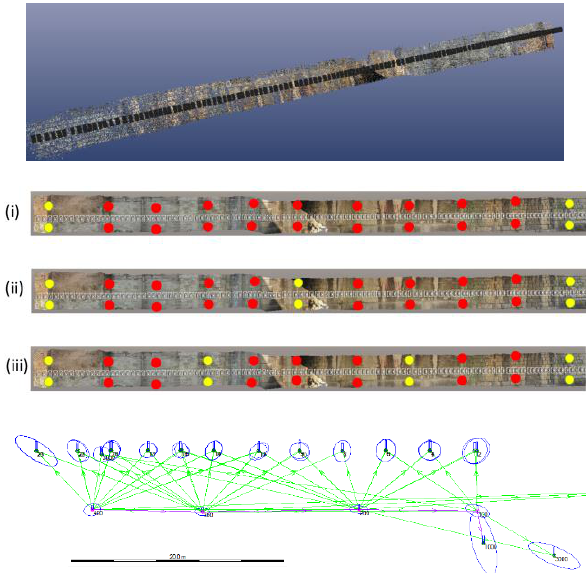
Figure 8. Ground control points (red) and check point (white) configurations for the linear